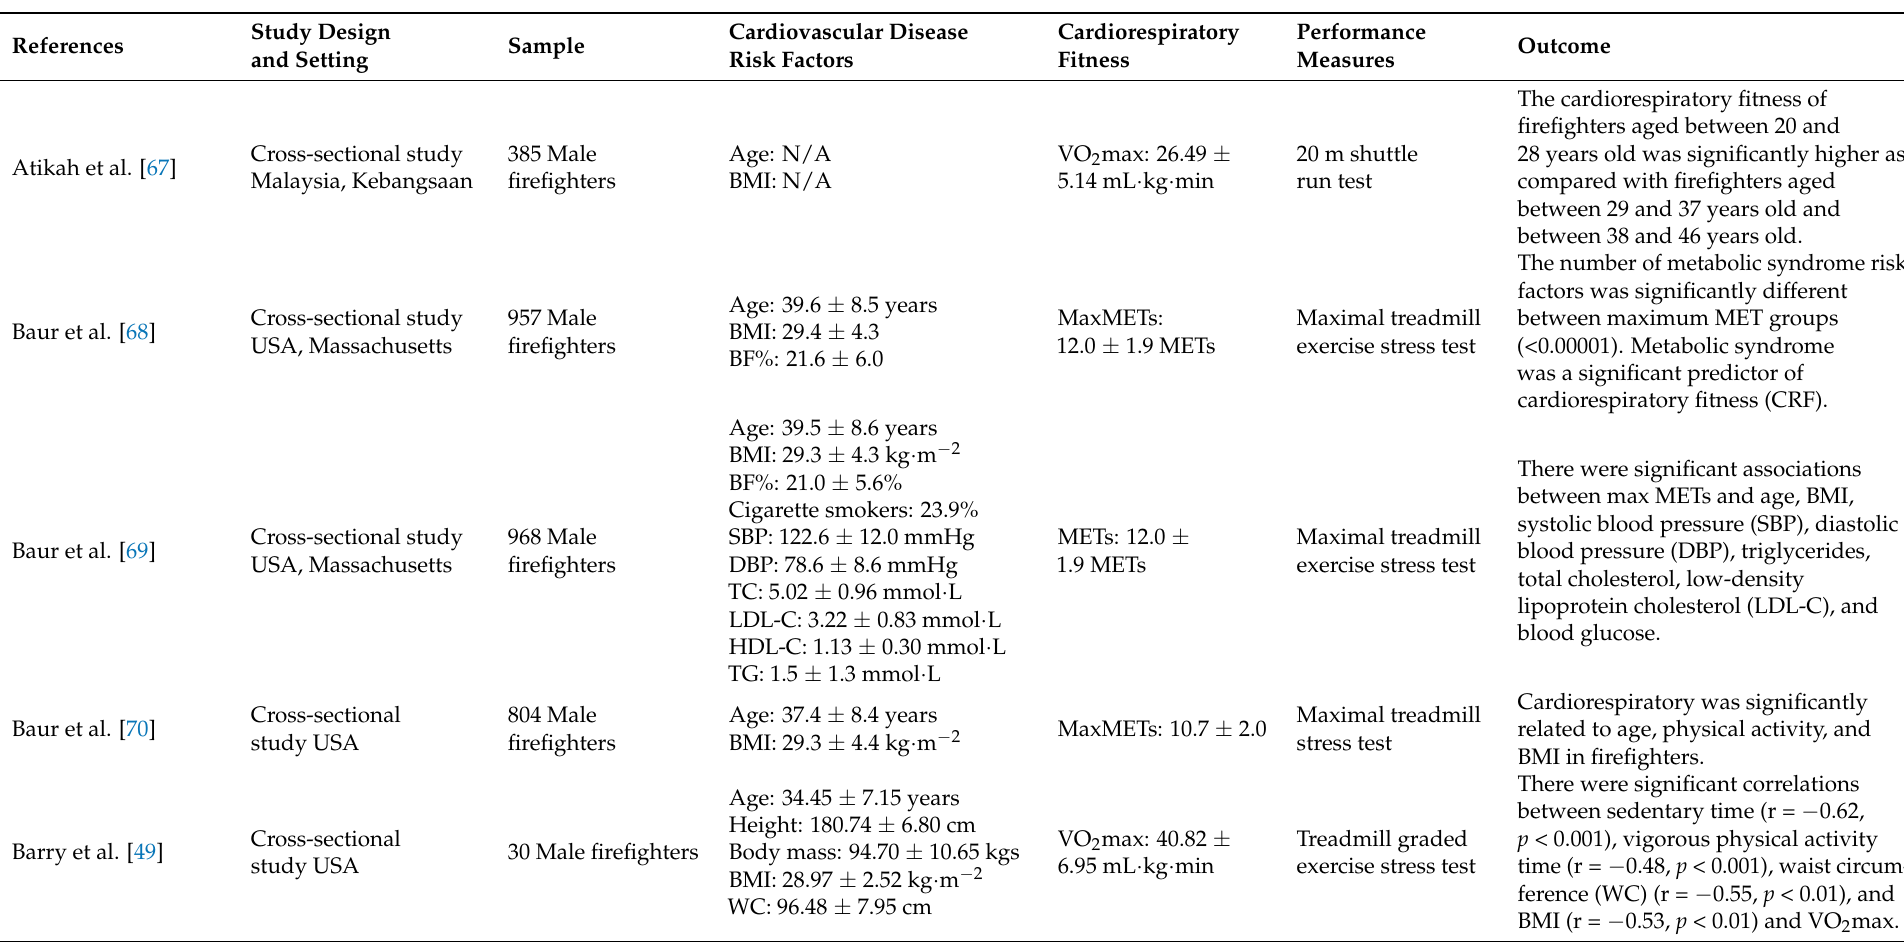
Table 1. Characteristics of included studies in the narrative synthesis and quantitative